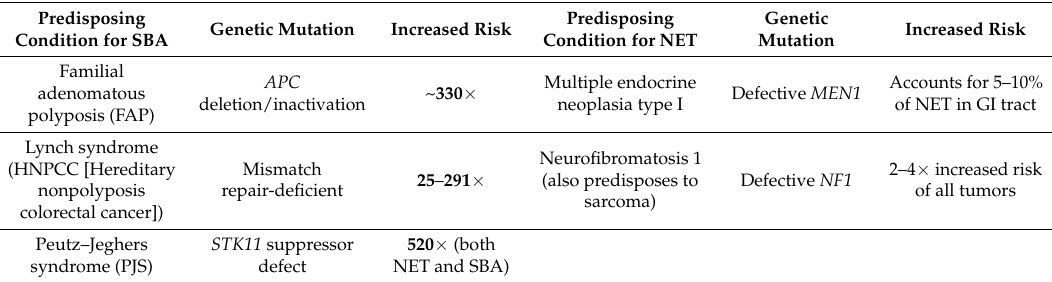
Table 2. Hereditary mutations associated with small bowel adenocarcinoma (SBA), neuroendocrine tumors (NETs), and increased risk of